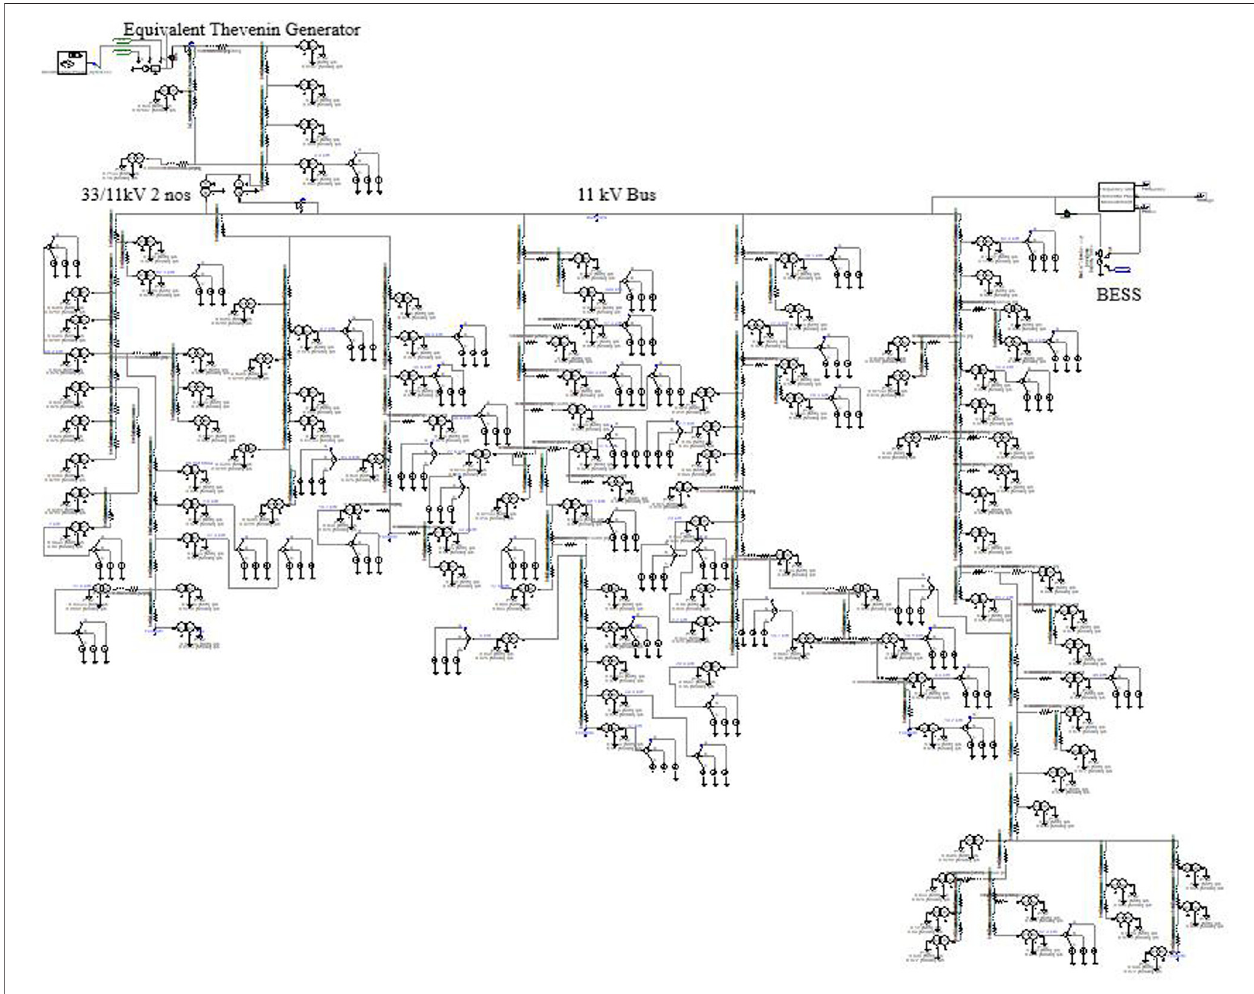
FIGURE 8 | Modeled power distribution feeder.